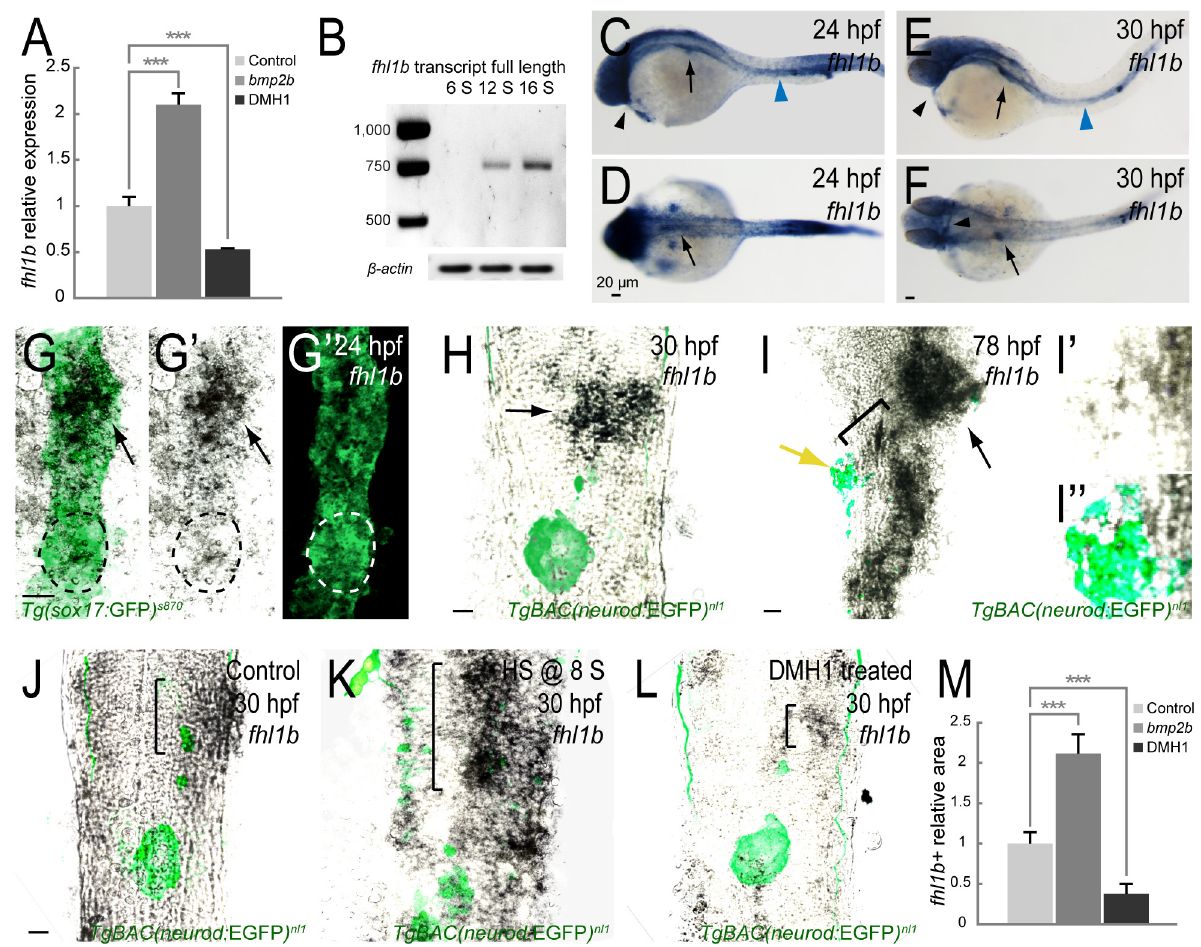
Fig 1. fhl1b is a target of the Bmp2b pathway. (A) Quantitative real-time PCR analysis of fhl1b in bmp2b -overexpressing or DMH1-treated embryos at 20 hours-post-fertilization (hpf). Gene expression was normalized to that of β -actin and presented as fold changes (mean ± SD) against control expression. Asterisks indicate statistical significance: *** , P < 0.001. (B) fhl1b full-length transcript, which was detected by RT-qPCR analysis of whole embryos, starts to be expressed from the 12-somite stage onwards. (C-F) Whole-mount in situ hybridization showing the expression of fhl1b at 24 (C-D) and 30 (E-F) hpf. At 24 hpf (C-D), fhl1b is expressed in the anterior part of the endoderm, which corresponds to the prospective liver anlage (black arrows). Additionally, fhl1b is expressed in the pronephric duct (blue arrowhead) and heart (black arrowhead). At 30 hpf (E-F), fhl1b continues to be highly expressed in the liver (black arrows) and remains to be expressed in the pronephric duct (blue arrowhead) and heart (black arrowheads). (G-G ” ) Double antibody and in situ hybridization staining of fhl1b at 24 hpf in Tg(sox17 : GFP) s870 embryos. fhl1b is primarily expressed in the anterior part of the endoderm, which corresponds to the prospective liver anlage (black arrows). White and black dotted circles locate the dorsal pancreatic bud, which gives rise exclusively to the principal islet, a cluster of endocrine cells. A merged view of G ’ and G ” is shown in G. (H-I ” ) Double antibody and in situ hybridization staining of fhl1b in TgBAC(neurod : EGFP) nl1 embryos at 30 (H) and 78 (I-I ” ) hpf. TgBAC(neurod :EGFP ) nl1 expression marks the posteriorly located pancreatic endocrine cells. At 30 hpf (H), fhl1b is highly expressed in the liver (black arrow). At 78 hpf (I-I ” ), the level of fhl1b expression is continuously high in the liver (black arrow) and in patches of cells in the distal intestine, low in the HPD system (black bracket), and absent in most of the pancreatic cells except for a few cells in the periphery of the principal islet (yellow arrow). In the principal islet, fhl1b expression is confined to the peripheral boundary and does not significantly overlap with the TgBAC (neurod :EGFP ) nl1 expression. Magnified images of fhl1b and TgBAC(neurod :EGFP ) nl1 expression in the principal islet are shown in I ’ and I ” . (J-L) Double antibody and in situ hybridization staining showing the endogenous expression of fhl1b in the liver (black brackets), comparing control (J), bmp2b - overexpressing (K), and DMH1-treated (L) TgBAC(neurod : EGFP) nl1 embryos at 30 hpf. fhl1b expression was greatly expanded when bmp2b expression was induced at the 8-somite stage (K), but was reduced in DMH1-treated embryos (L). (M) Quantification of the fhl1b -positive in situ hybridization signal at 30 hpf. The areas of fhl1b -positive signal were selected and measured using Image J with normalization to control. 3 individual embryos were analyzed for each condition. Asterisks indicate statistical significance: *** , P < 0.001. G-L, confocal single-plane in situ hybridization images combined with the projection images of Tg(sox17 :GFP ) s870 (G-G ” ) and TgBAC(neurod :EGFP ) nl1 (H-L) expression, ventral views, anterior to the top. C and E, lateral views, anterior to the left. D and F, dorsal views, anterior to the left. n = 10 per each time point and condition. Scale bars, 20 μ m.